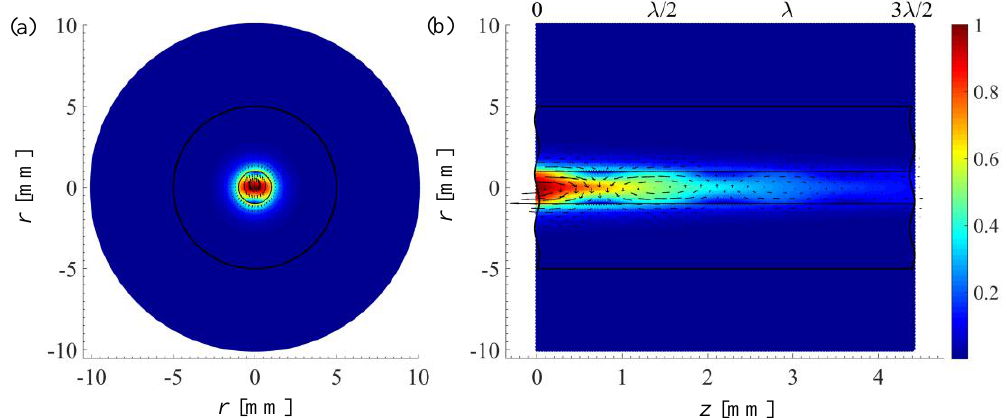
Figure 9. Electric field distributions of the fundamental “core” mode in the transverse ( a ) and longitudinal ( b ) cross-sections of the waveguide filled with blood cells at a frequency of 30 GHz.